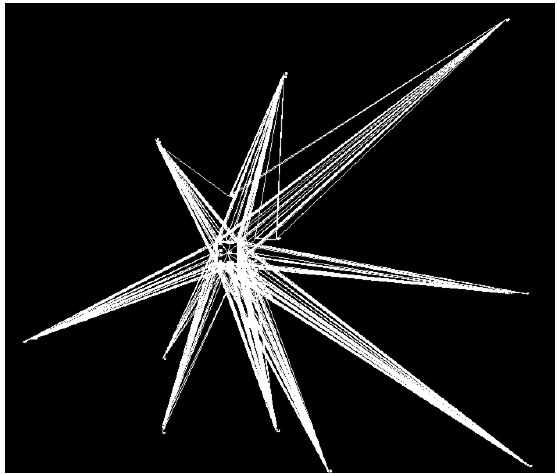
Figure 35 - A detail of the minaret from the textured 3D model (orthographic rendering) (by W.Wahbeh and